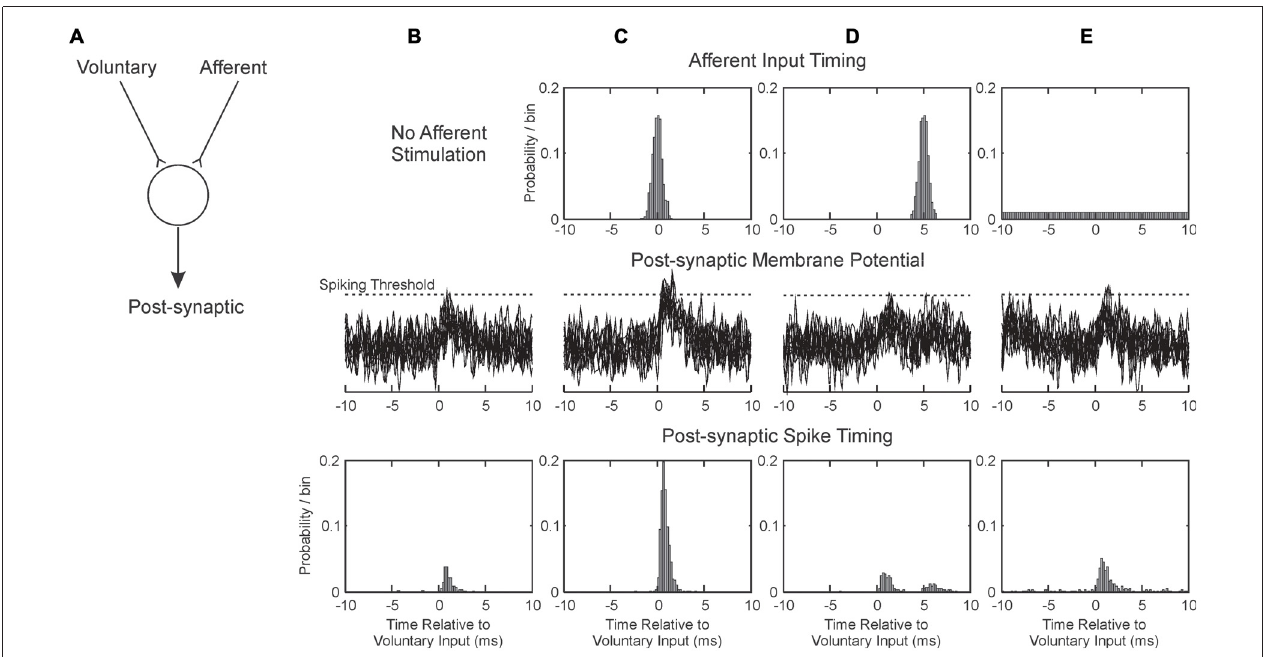
FIGURE 5 | Illustration of how pairing afferent stimulation with voluntary drive may produce conditions suitable for plasticity. (A) We consider a single post-synaptic cell receiving excitatory synaptic inputs from two sources: one activated by voluntary motor commands, and one from afferent input. These sum at the cell membrane; if they exceed spiking threshold, the post-synaptic cell generates a spike. Each column (B–E) illustrates a different situation of afferent activation. The three rows represent respectively the timing of the afferent input relative to the voluntary input (at time zero), overlain example traces of the post-synaptic membrane potential and the timing of the discharge of the post-synaptic cell. (B) Without afferent input. (C) Afferent input activated close in time to voluntary input. (D) Afferent input activated on average 5 ms after voluntary input. (E) Afferent input activated at random relative to the voluntary input. EPSPs were simulated as alpha functions, with rise time 1 ms. Amplitudes in arbitrary units were 0.6 for Voluntary and 0.5 for Afferent inputs; spike threshold was at 1.2. Post-synaptic cell membrane noise was modeled as Gaussian noise bandlimited to 2 kHz, standard deviation